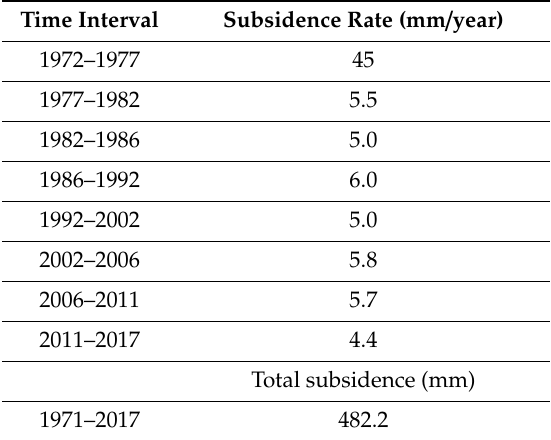
Table 2. Average subsidence rate (mm / year) over the entire basin extrapolated from Teatini et al. [32] and Arpae dataset.